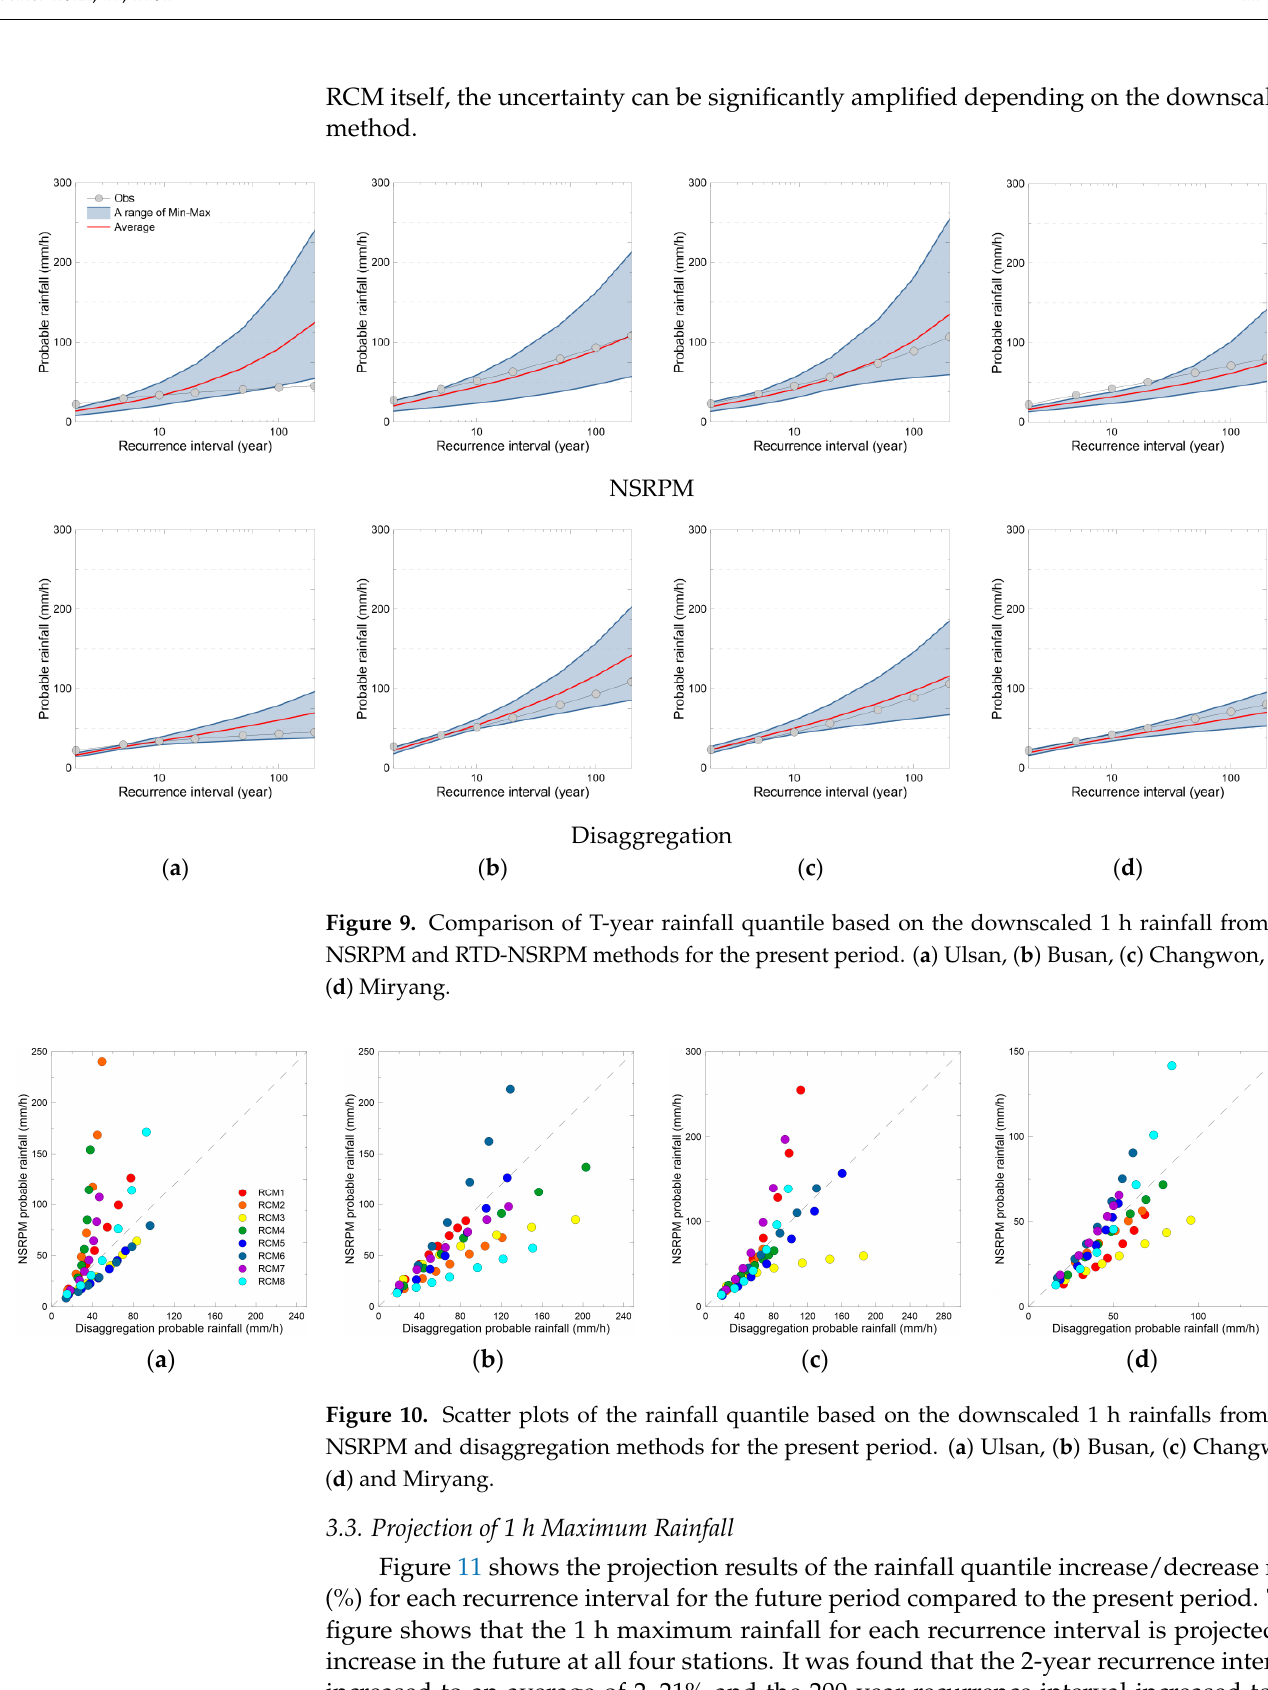
( d ) Figure 11. Change rate (%) of the future (2021–2050) T-year rainfall quantile based on the RTD- NSRPM method. ( a ) Ulsan, ( b ) Busan, ( c ) Changwon, and ( d ) Miryang. Considering that all eight RCM data applied were RCP 4.5 scenarios, in which efforts to reduce greenhouse gases have been partially effective, the region located downstream of the Nakdong River is likely to increase the hourly maximum rainfall/rainfall quantile. It was confirmed that the probability that the rainfall quantile for the recurrence interval less than 50 years in the future could be greater than the rainfall quantile for the recurrence interval of 200 years in the present period. In particular, in the case of the Ulsan station, the future rainfall quantile for the 20-year recurrence interval is greater than that in the